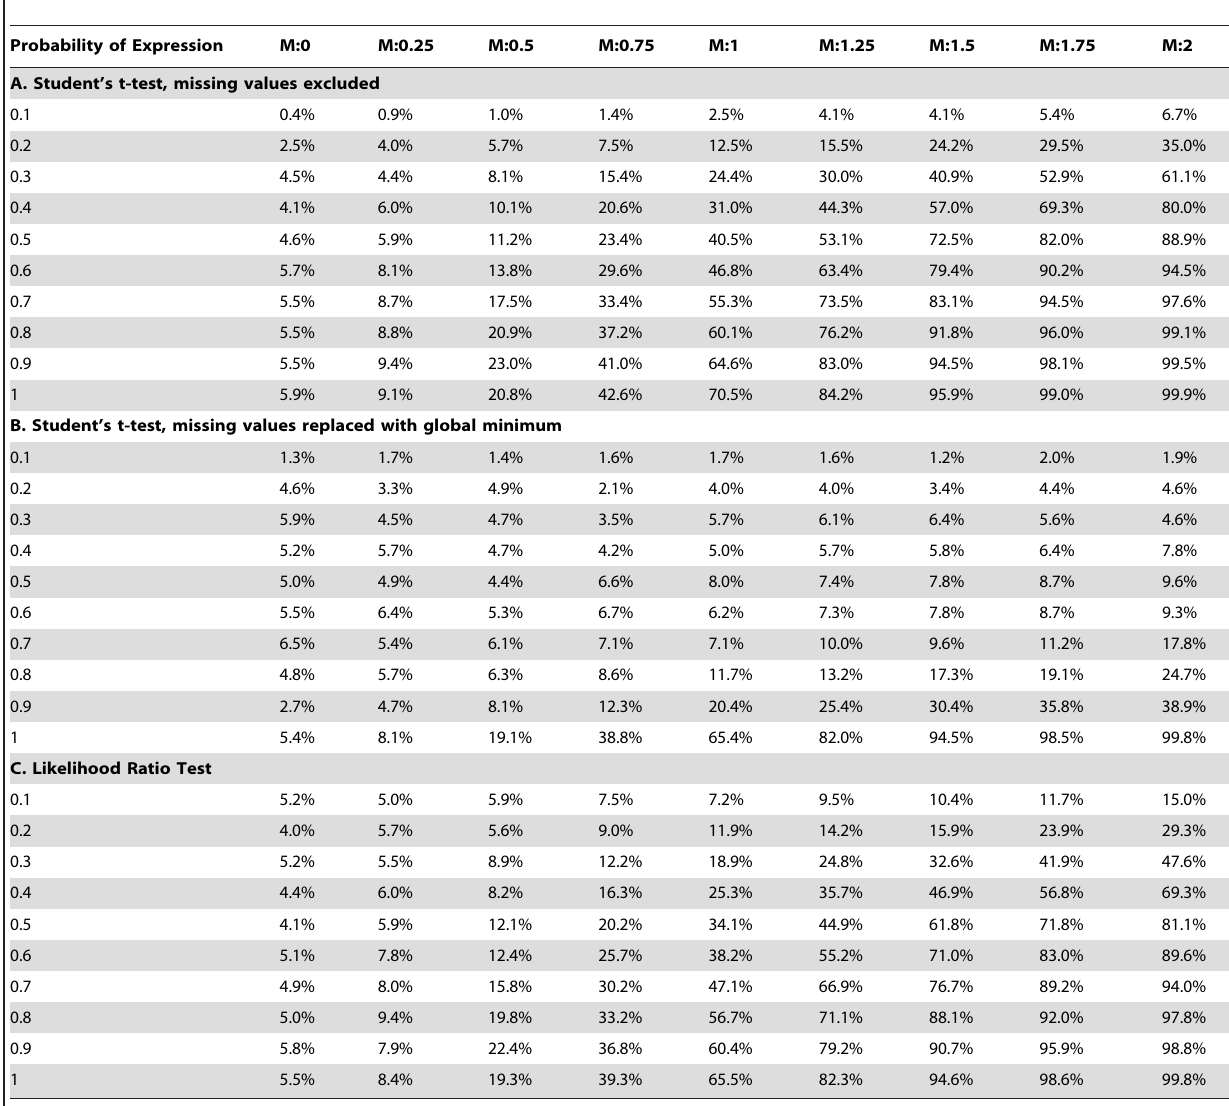
Table 4. Result for different mean expression intensities and same probability of expression between two groups.